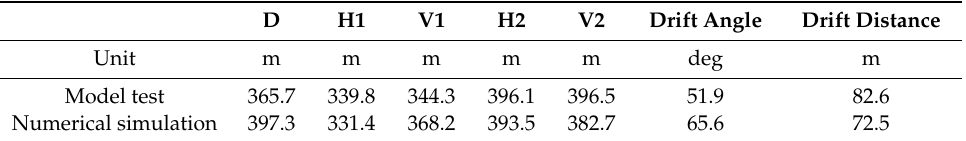
Table 1. Parameters of the turning trajectories in calm water and